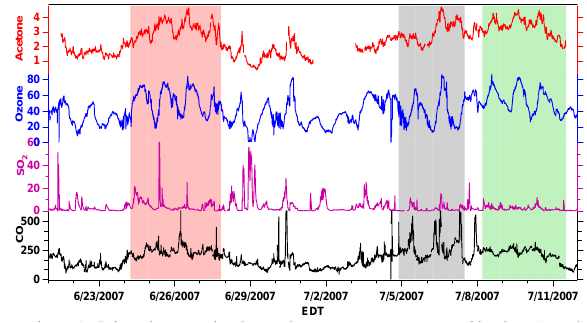
Figure 4. Selected gas species time series. Acetone was measured by the PTR-MS, whereas the others by standard air quality measurement instruments. Units are in ppbv. Red, black and green shaded periods refers to different air mass episodes: Processed Air, Detroit Air, and Sulfate and Biogenic Air, respectively.